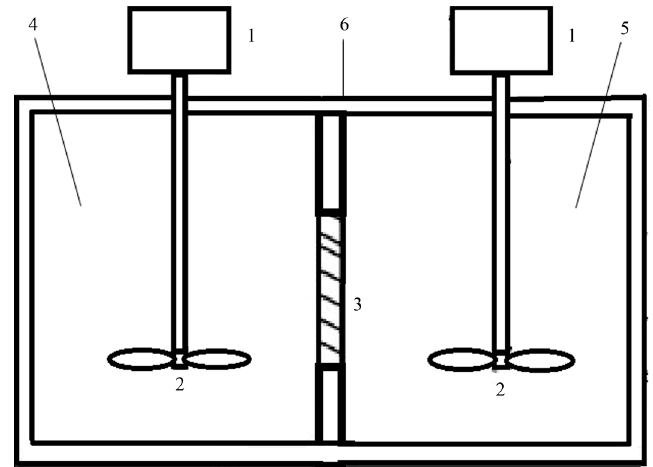
Figure 1. Flat-sheet supported liquid membrane (FSSLM) system used in the current study. 1: Motors, 2: agitators, 3: flat-sheet membrane chamber, 4: feed phase, 5: strip phase, 6: Plexiglass body.